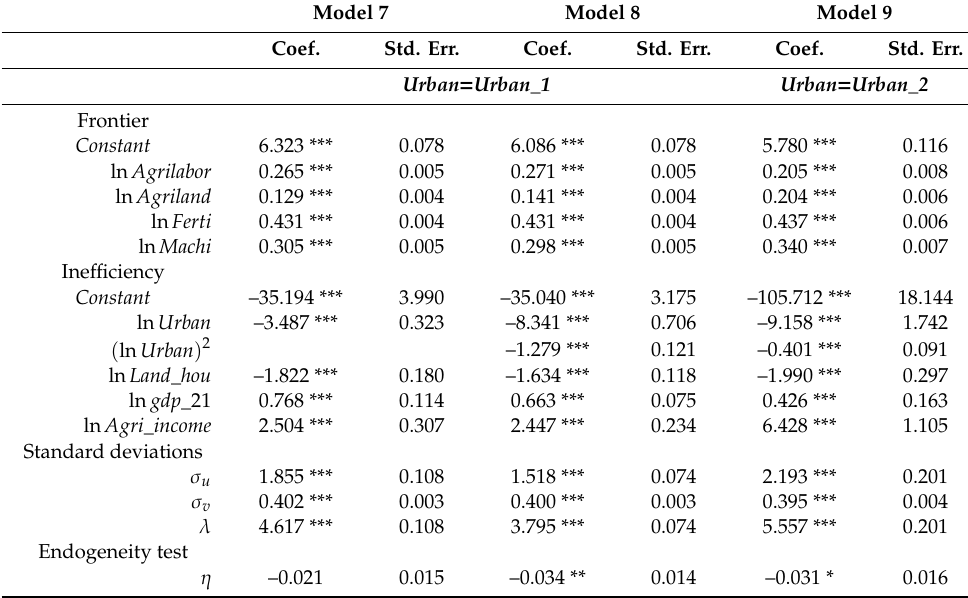
Table 3. The results of empirical test after considering endogeneity